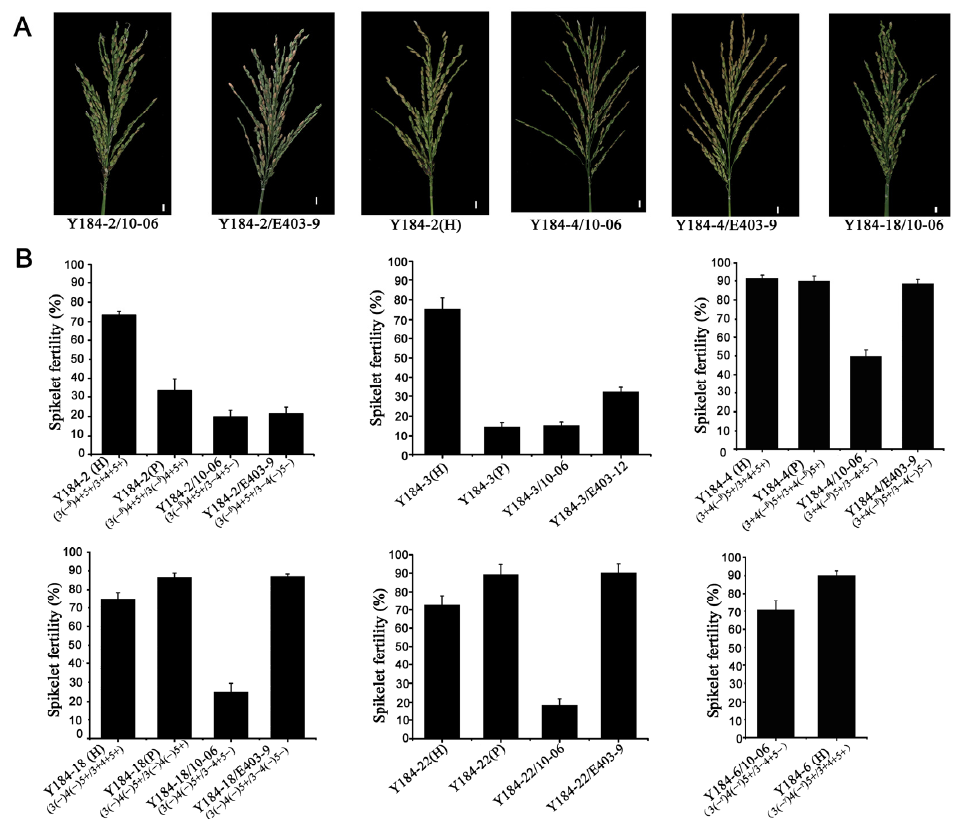
Figure 5. Knockout of both ORF3 and ORF4 by CRISPR/Cas9 resulted in lower hybrid fertility ( A ) Spikelet fertility in the panicles in F 1 hybrids from six crosses. Scale bar in panicles, 1 cm. ( B ) Spikelet fertility in hybrids F 1 from the crosses of gene-edited mutations in the SSSL 14-06 background with 10-06. The genotypes of the parents in the crosses were in parentheses, ORF3 , ORF4, and ORF5 were abbreviated as “3”, “4”, and “5”. Error bars represent SD, n = 10.